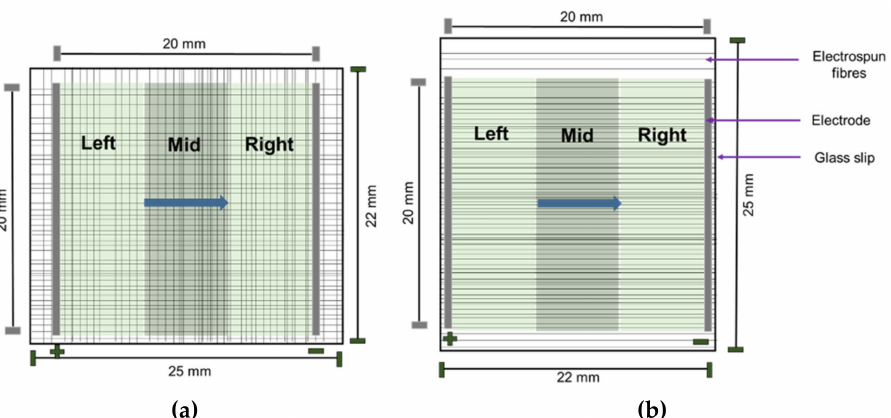
Figure 3. Schematic illustrating non-aligned fibers ( a ) and aligned fibers ( b ). The blue arrow repre- sents the direction of the EF. The green area represents area of the EF (20 mm × 20 mm) on glass slips (25 mm × 22 mm). Cell locations are classified as left, mid, and right depending on the position of the cells in relation to the EF as depicted